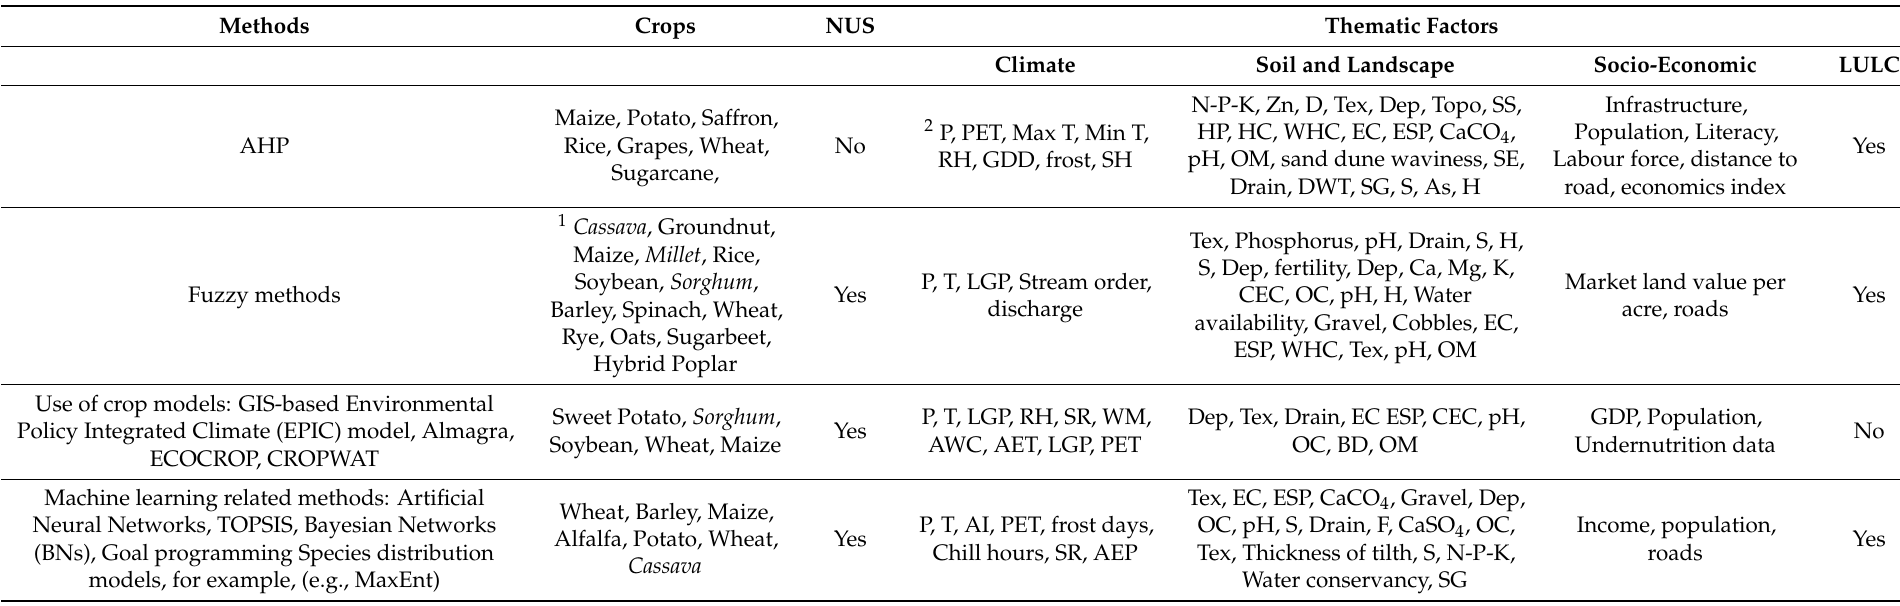
Table 3. A description of modern methods used in land suitability assessments. References to the showcased methods can be found in the Supplementary